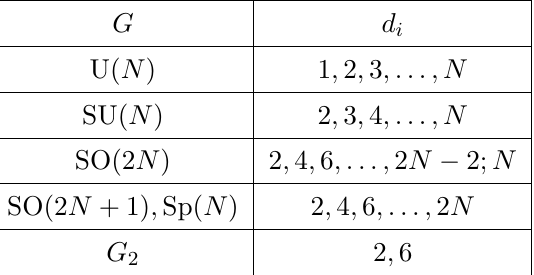
Table 1 . The dimensions d i of generating Casimir operators for gauge groups G